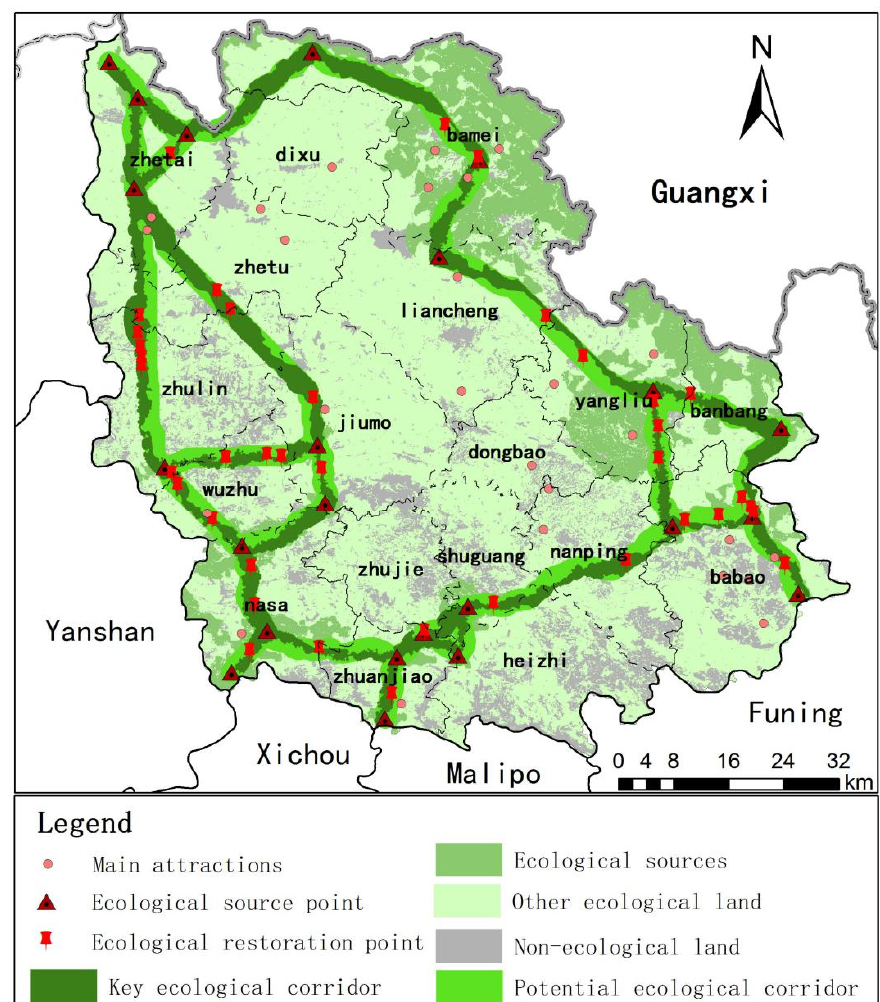
Figure 8. Ecological security pattern in Guangnan County.